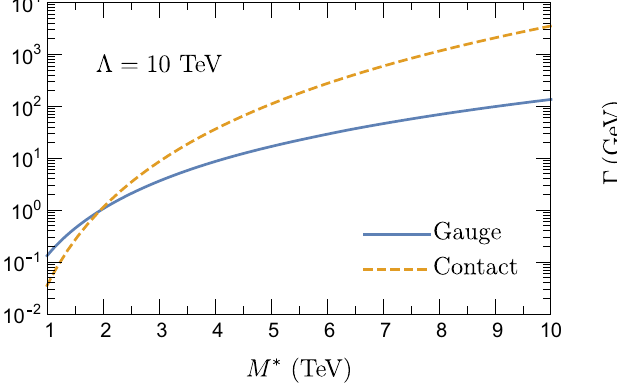
different values of (cid:3) , assuming a composite neutrino mass M ∗ = 10 TeV. The gauge couplings are evaluated at the scale M ∗ , whereas | ˜ f | 2 = |˜ η | 2 ≡ I α I α